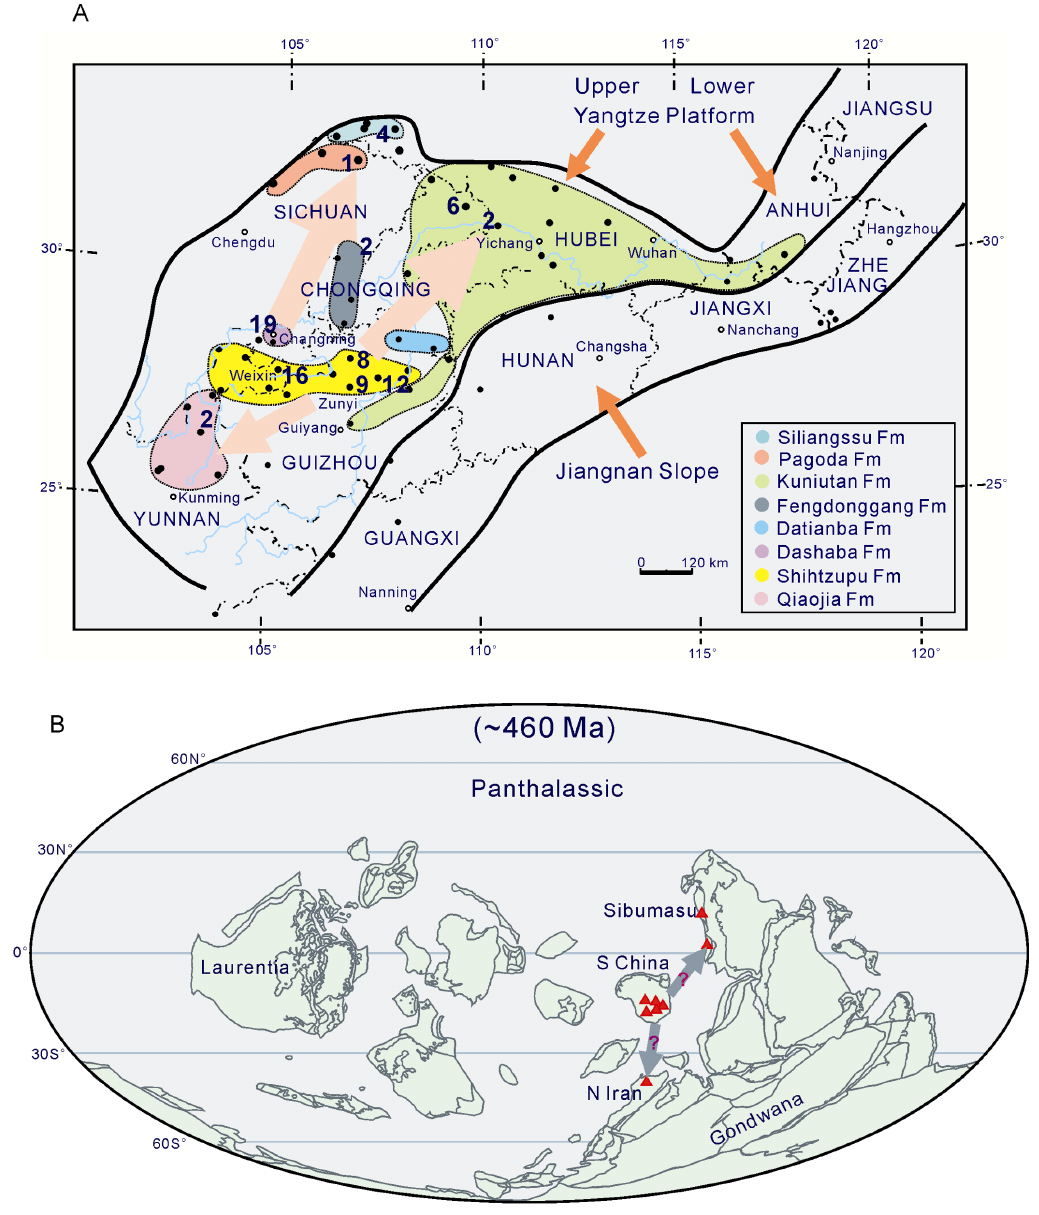
Fig. 2. Geographic and palaeogeographic distributions of the Saucrorthis Fauna. A , Darriwilian lithological units developed on the Upper and Lower Yangtze Platform of the South China palaeoplate, and the diversity change of the Saucrorthis Fauna from the Shihtzupu and Dashaba formations to the Kuniutan, Qiaojia, Fengdonggang and Siliangssu formations (modified from Liang & Zhan 2012). Numbers 1(cid:150)19 in the map represent the number of brachiopod genera of the Saucrorthis Fauna at each particular locality on the Upper Yangtze Platform. Hollow circles indicate the cities and solid circles the section sites we investigated. B , regional distribution of the Saucrorthis Fauna (indicated by red solid triangles) showing its marginal Gondwanan affinity and possible migration routes (base map after Torsvik & Cocks